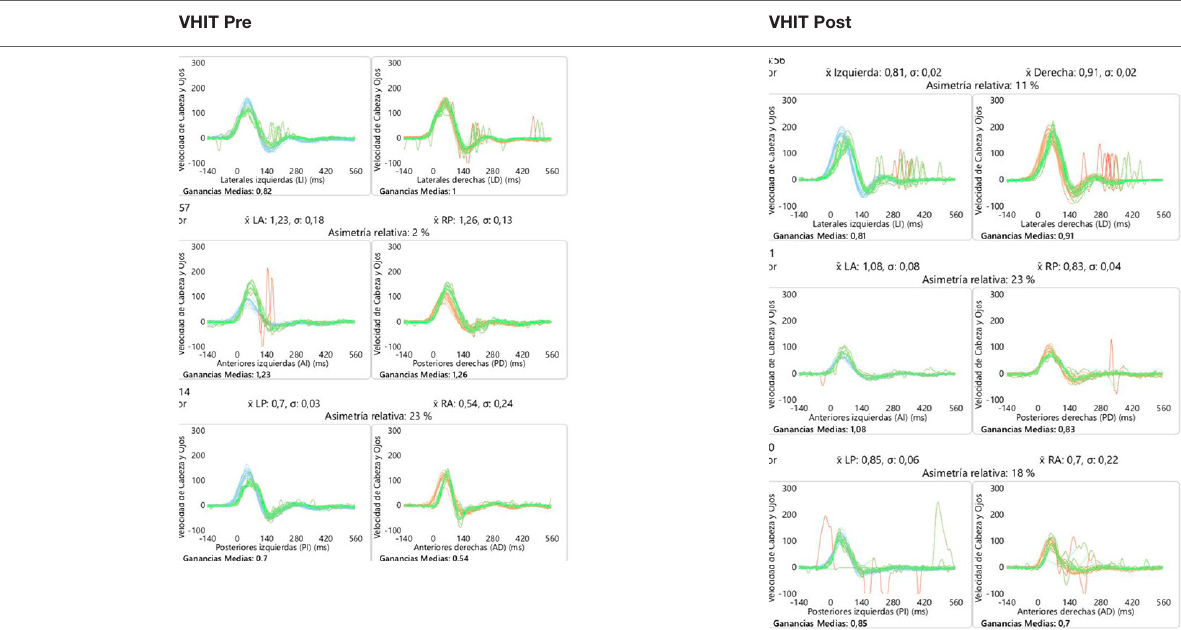
TABLE 6 | An example of VOR gain in six canals (VHIT) before and after cochlear implant group (example of C1